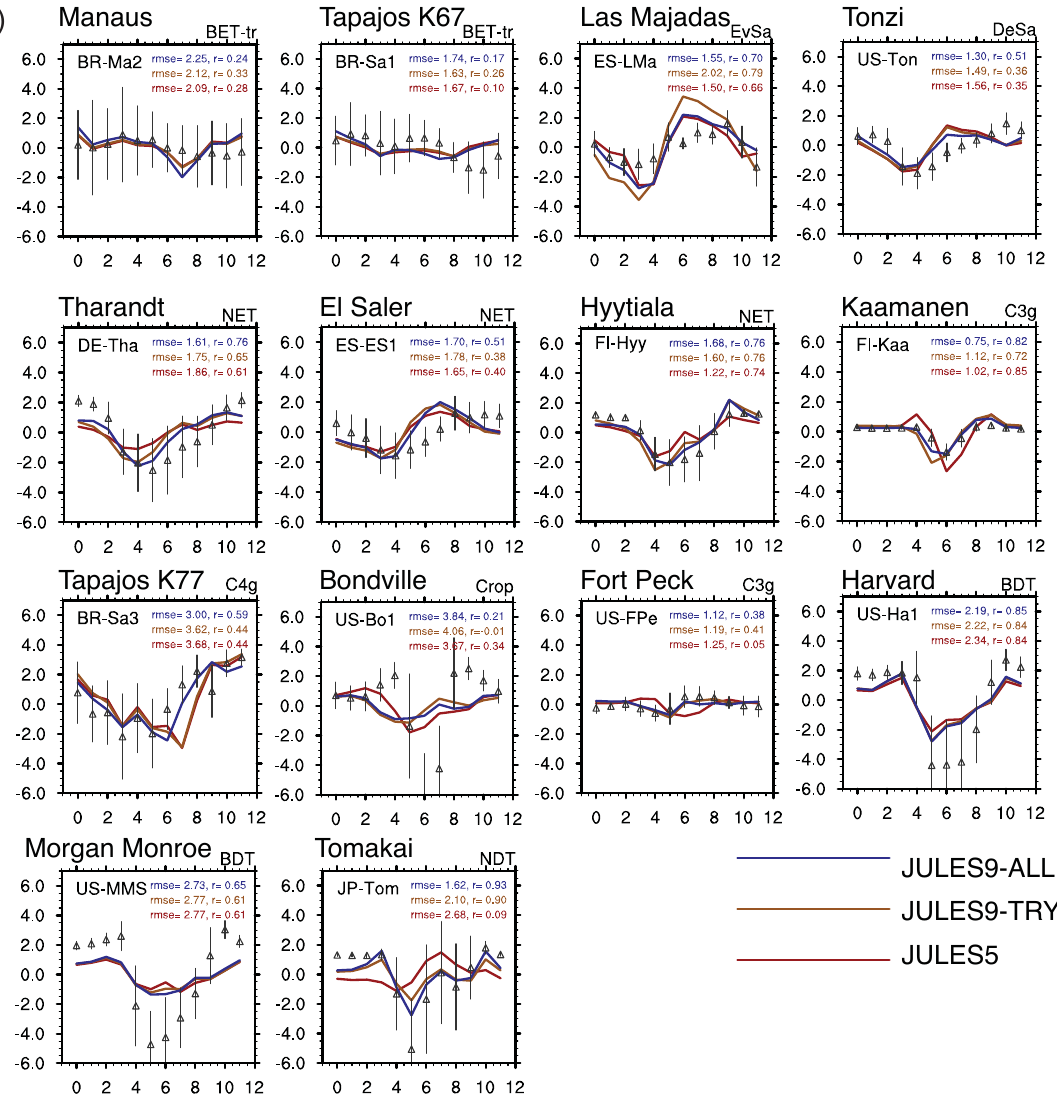
Figure 5. (a) Monthly mean fluxes of GPP. Observations ± standard deviation from FLUXNET are shown with triangles and vertical lines. The three JULES simulations are JULES5 with standard five PFTs (JULES5, red); JULES with nine PFTs and new LMA, N m , and V cmax,25 from TRY (JULES9 TRY , orange); JULES9-TRY plus new parameters for the PFTs as discussed in Sect. 2.3 (JULES9 ALL , blue). Also shown are the daily root mean square error (RMSE) based on daily fluxes and the correlation coefficient ( r ) based on monthly mean fluxes for all years of the simulations. Site information is given in Table 3. All units are in gCm − 2 d − 1 . (b) As in (a) but for monthly anomalies of